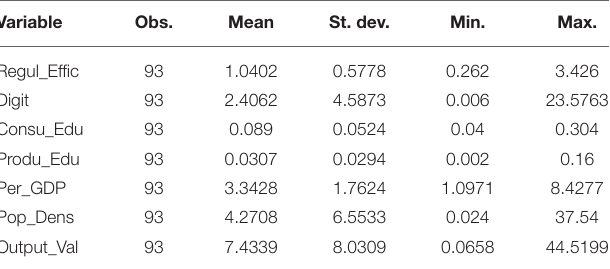
TABLE 2 | Descriptive statistics.